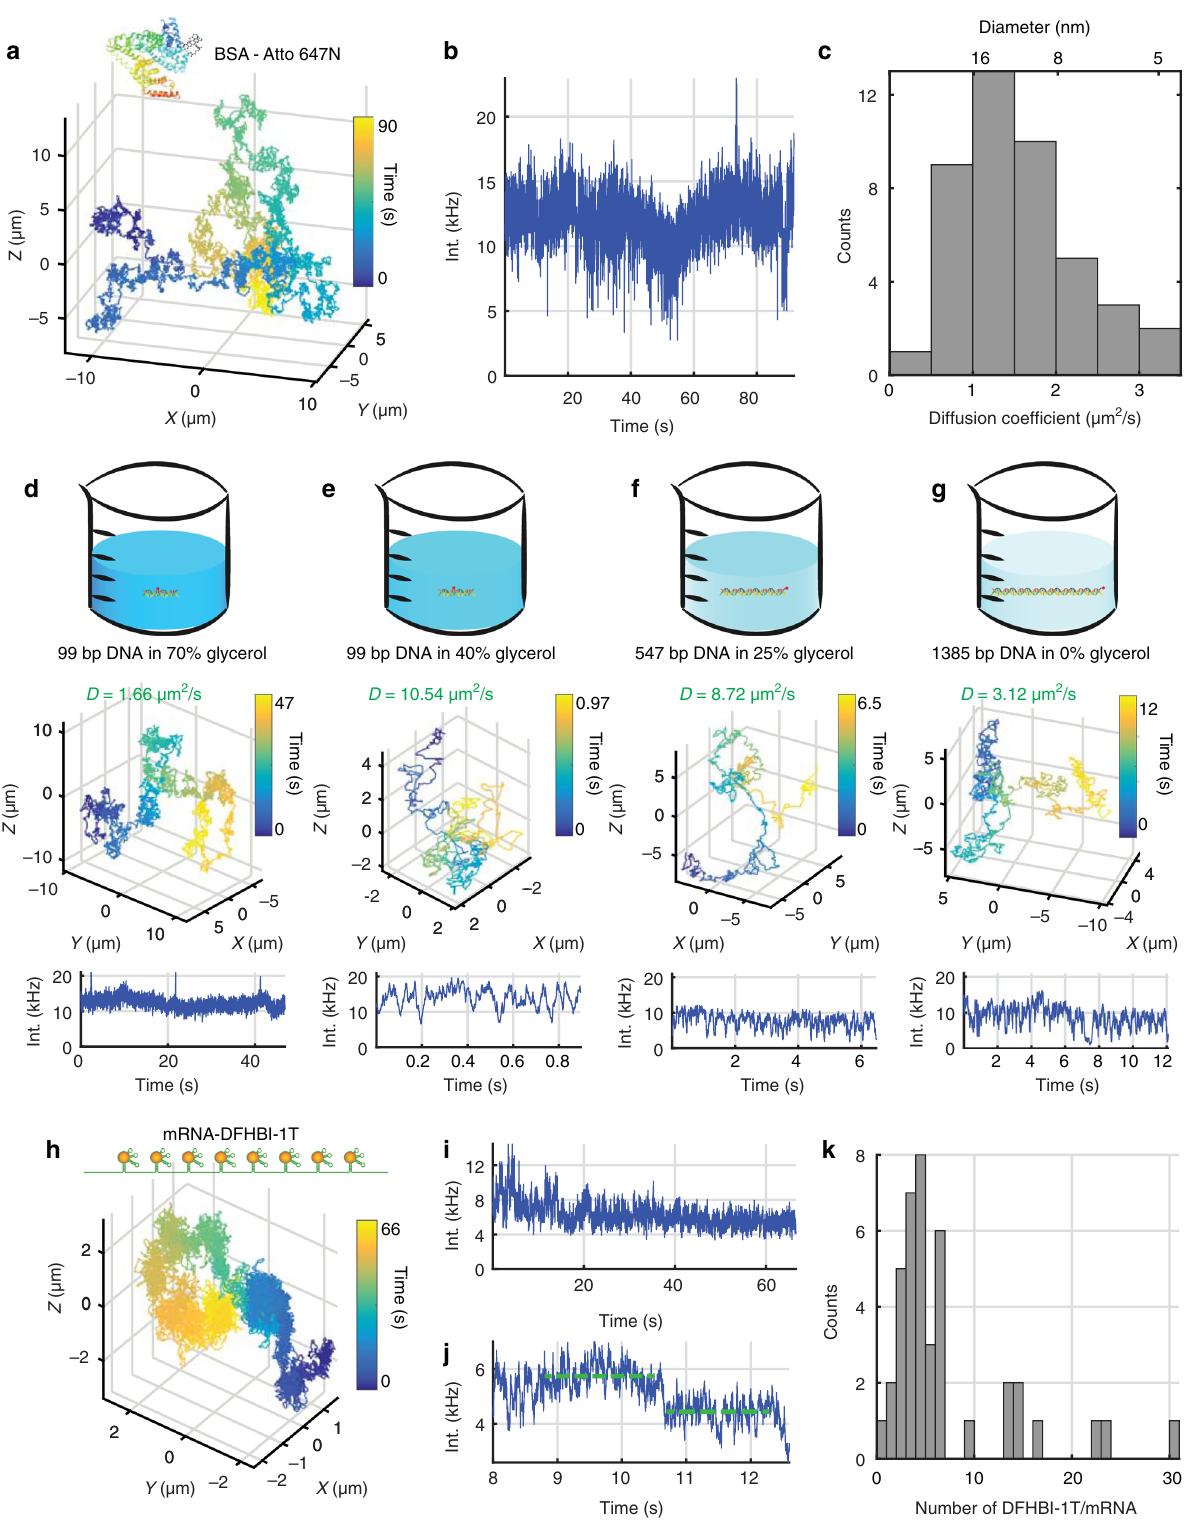
Fig. 3 Application of 3D-SMART to biomolecules. a – c , 3D trajectory, intensity trace, and histogram of diffusion coef fi cients for single BSA molecules in 73.5 wt% glycerol (number of trajectories n = 43, bin siz = 0.5 μ m 2 /s). d – g Tracking a range of dsDNA lengths at indicated glycerol concentrations. d 99 bp dsDNA tracking in 70 wt% glycerol-water solution. e 99 bp dsDNA tracking in 40 wt% glycerol. f 547 bps dsDNA tracking in 25 wt% glycerol. g 1385 bp dsDNA tracking in PBS solution. h , i 3D trajectory and intensity trace of DFHBI-1T labeled single Spinach RNA aptamers tracking in 75 wt% glycerol. j Stepwise bleaching is used to calculate the intensity of single DFHBI-1T dye. k The histogram of the number of DFHBI-1T for single Spinach RNA aptamers (number of trajectories n = 41, bin size =